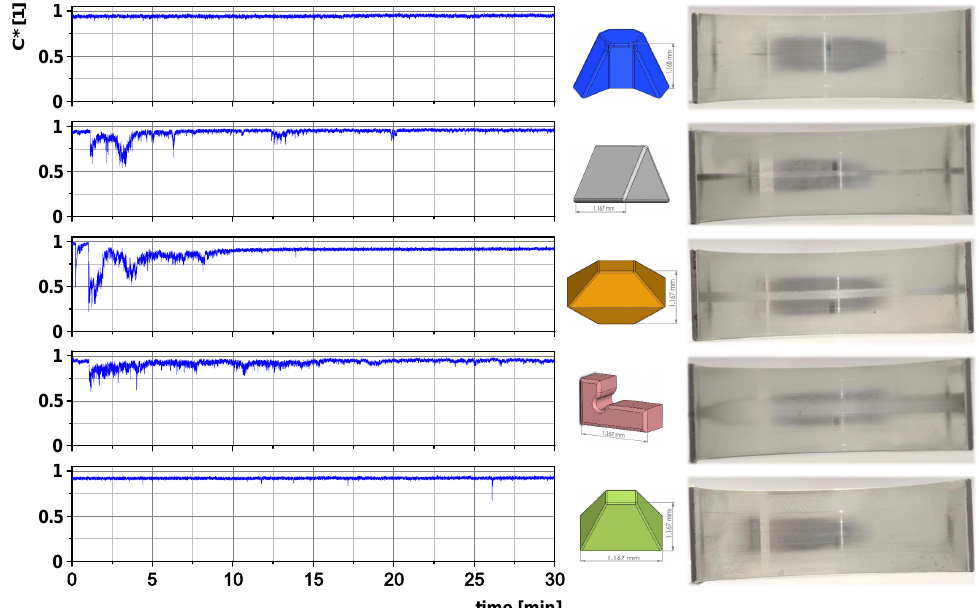
Figure 15. Mixed friction behavior of different particle